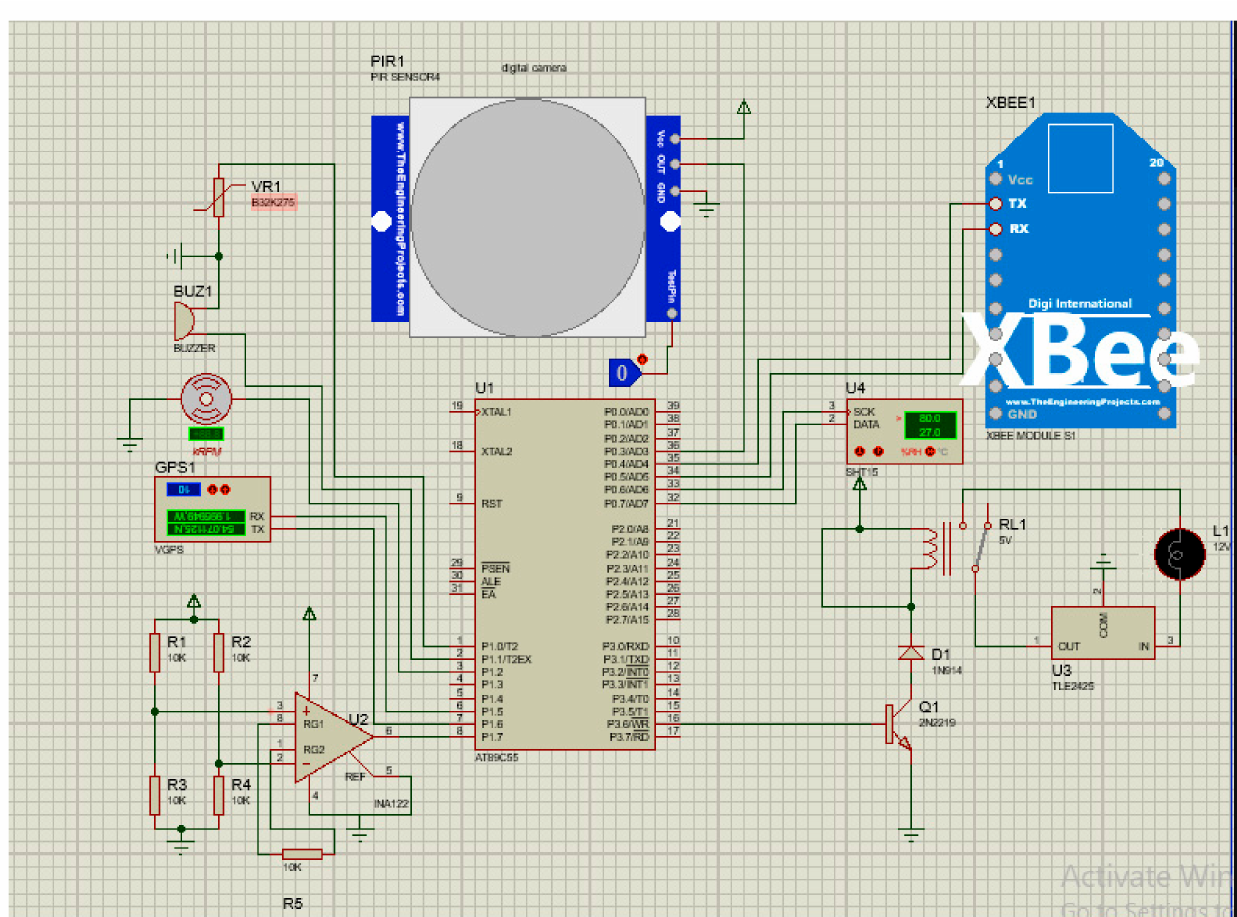
Figure 2. Schematic design of